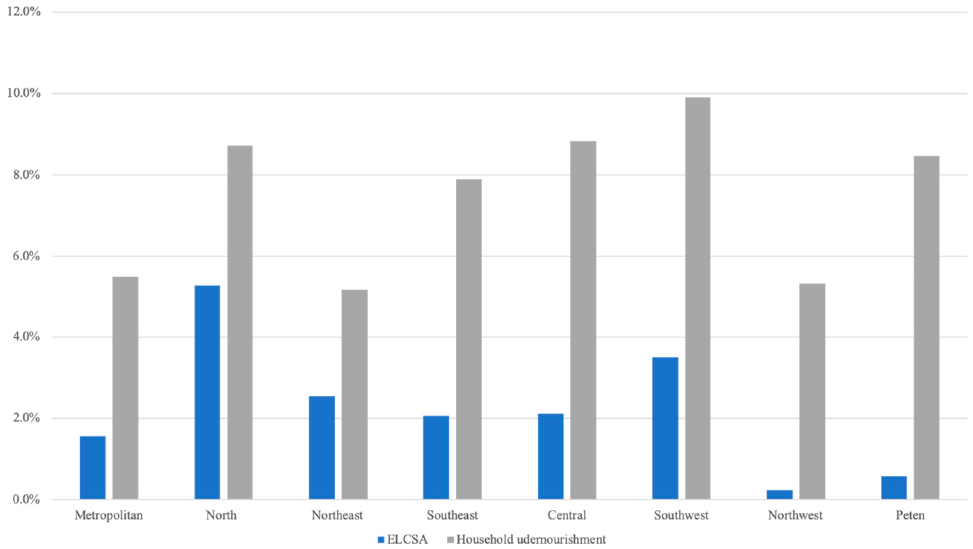
Figure 4. Percentage reduction in the incidence of food insecurity from a simulated cash transfer policy. ELCSA, Latin American and Caribbean Food Security Scale.